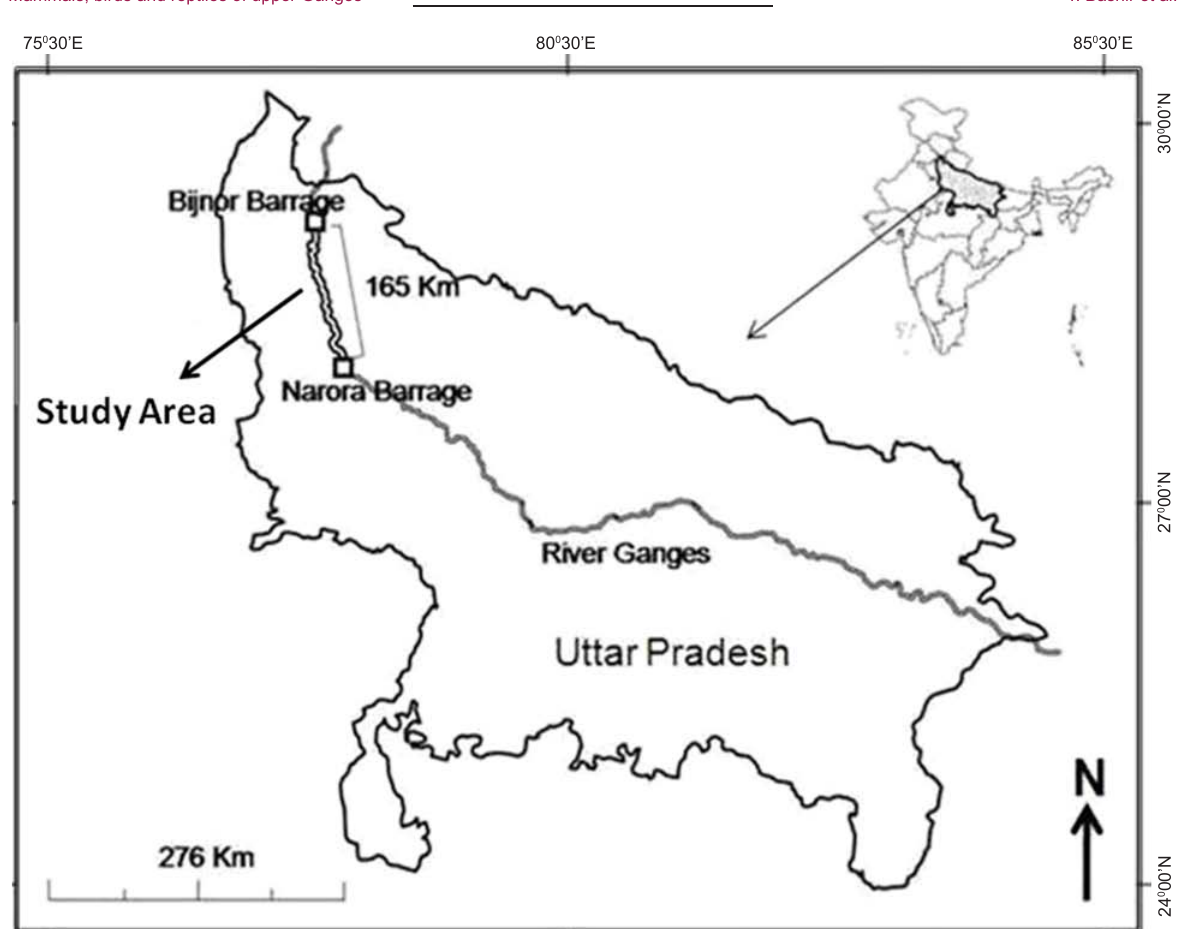
Figure 1. The location of the study area in Uttar Pradesh, India. Source :